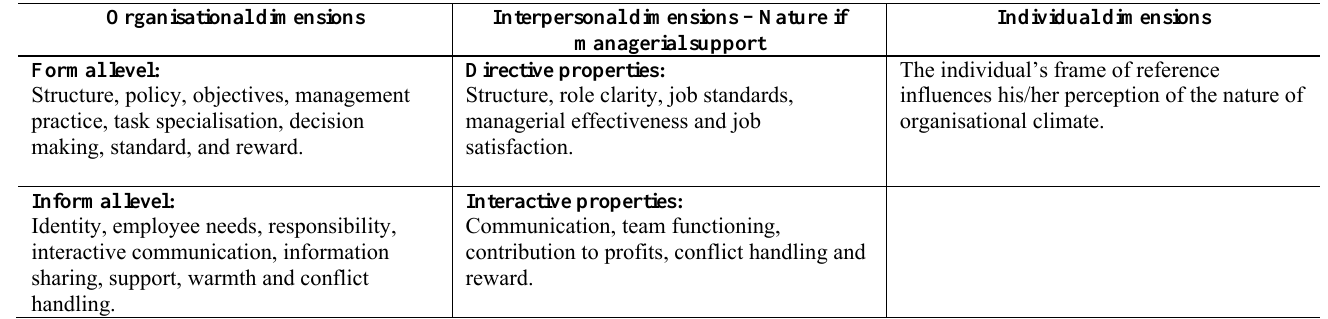
Table 2: Dimensions of organisational climate Organisational dimensions Interpersonal dimensions – Nature if managerial